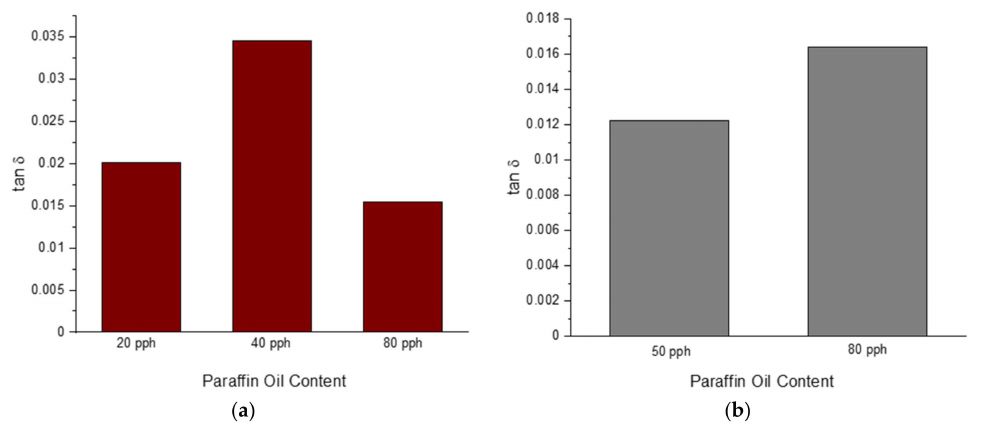
Figure 25. The influence of paraffin oil content on tan δ for a blend with 1.5 pph ( a ) and 2.5 pph of sulfur ( b ).